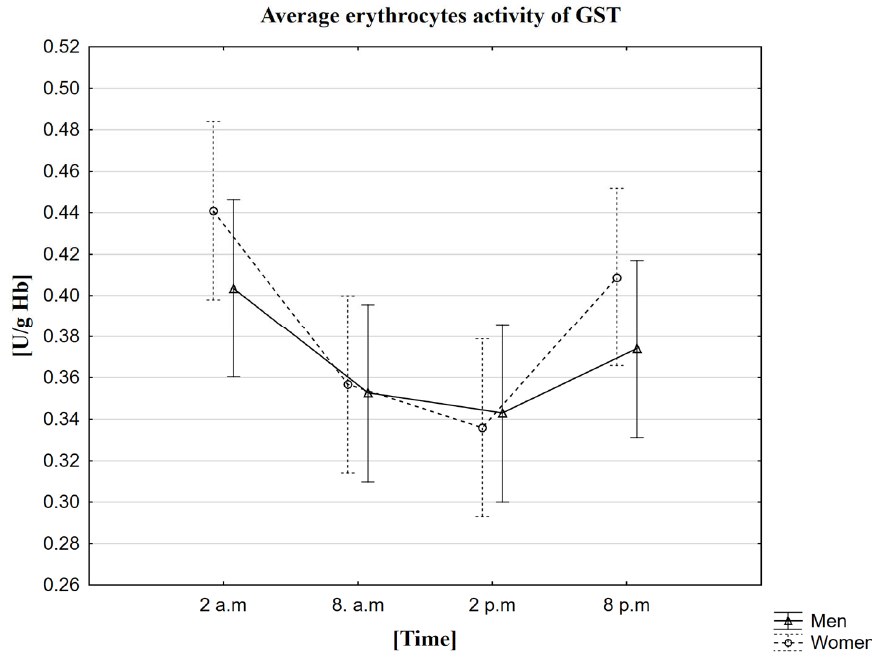
Table 7. Parameters describing glutathione transferase (GST) activity in women and men, including the time of blood collection (U/g Hb).